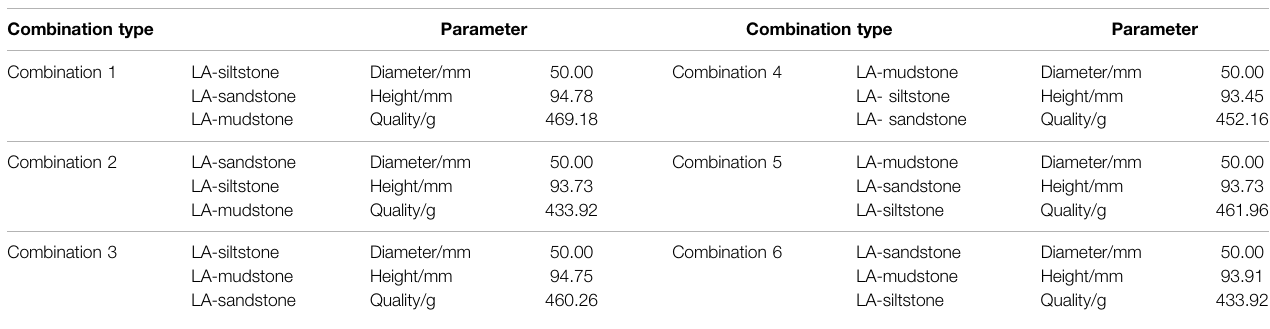
TABLE 1 | Basic parameter table of the samples of different lithological surrounding rock